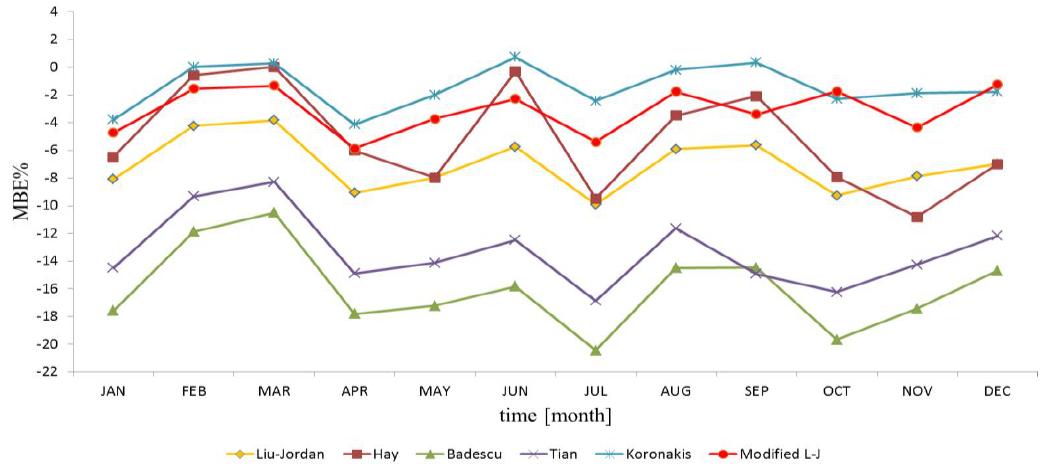
Figure 7. The differences in RMSE% of incident solar radiation of multiple models for a plane facing south at an inclination angle of 60° located in Poznań, Poland.